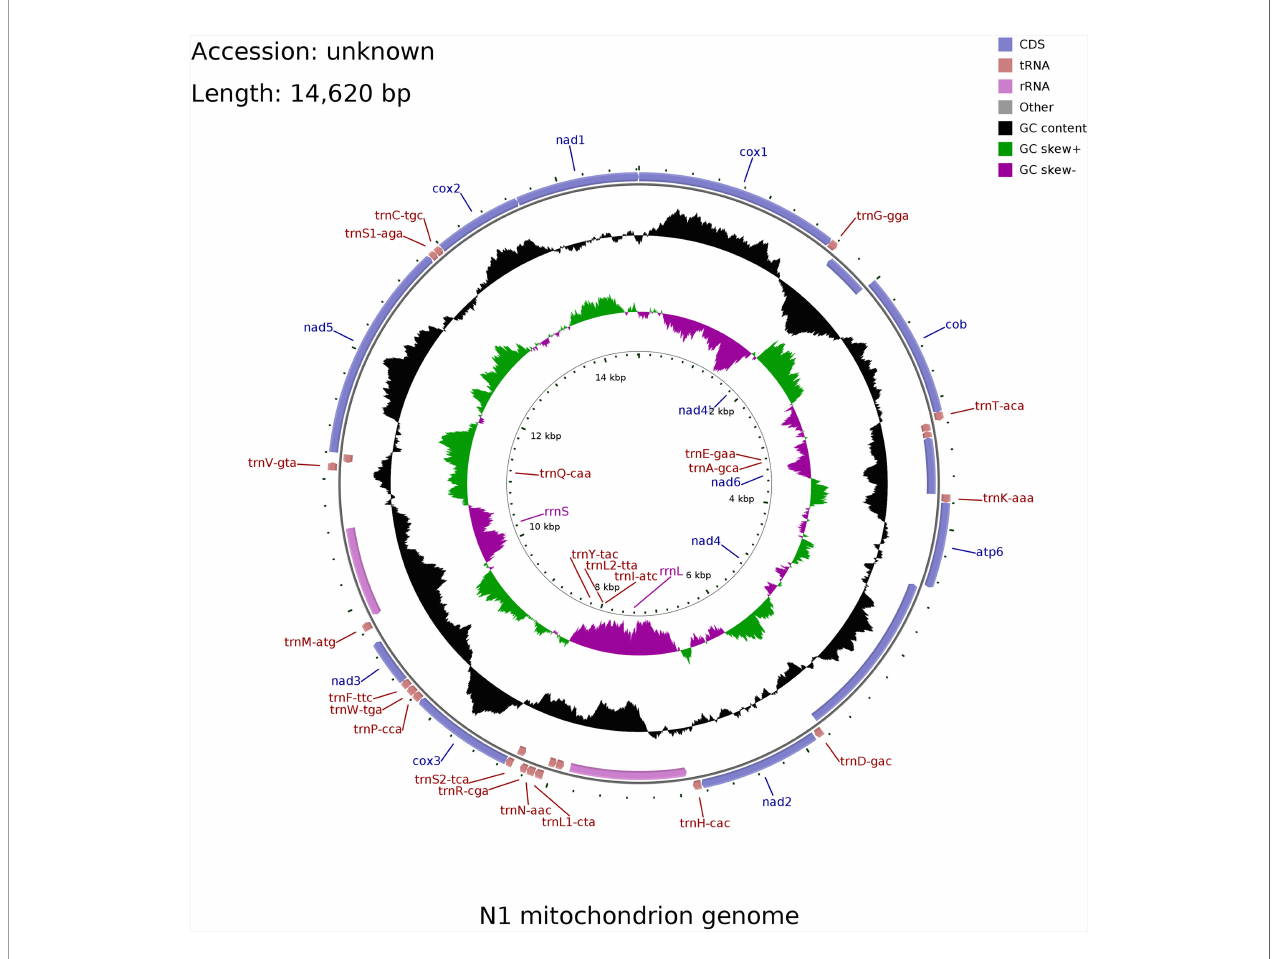
FIGURE 3 | Gene map of the Pennella sp. complete mitochondrial